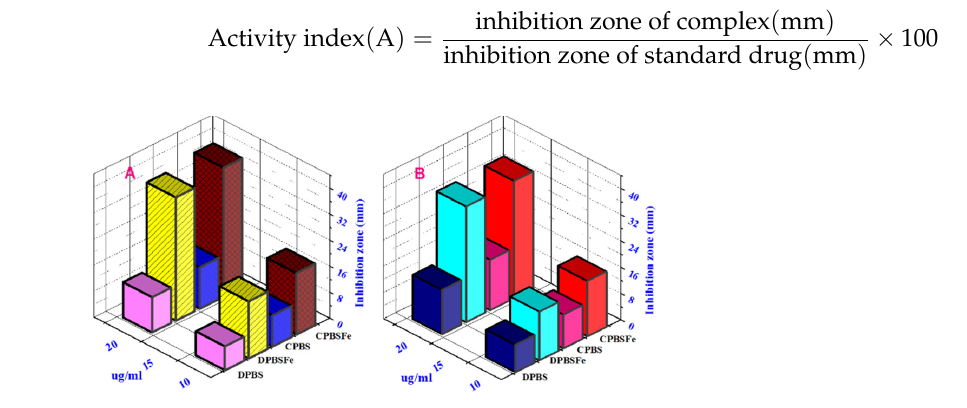
Figure 7. Antimicrobial efficacy for the compounds under investigation against ( A ) M. Luteus bacteria and ( B ) C. Candidum fungi.